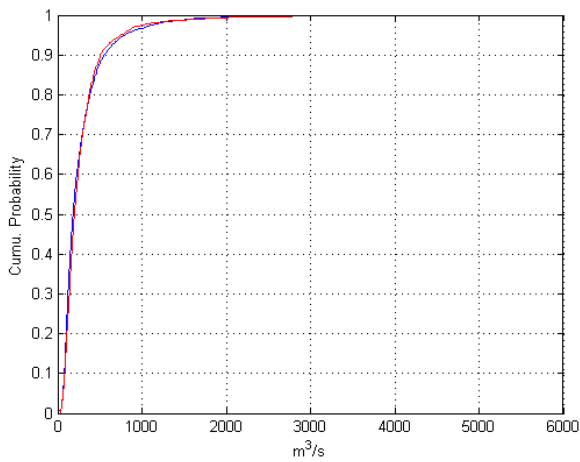
Figure 10. HSPF model output and observations. The top panel shows the modeled and observed 6- hour total precipitation at Zhangping.